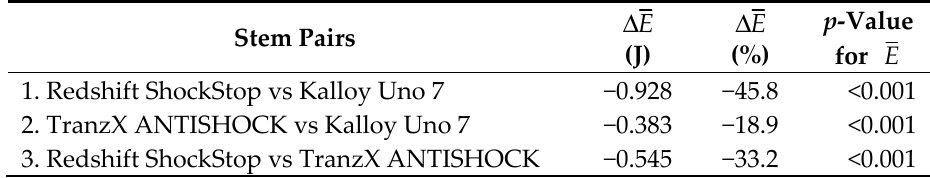
Table 2. Change in average total transmitted energy to the cyclist’s hands for pair-wise comparisons between the three